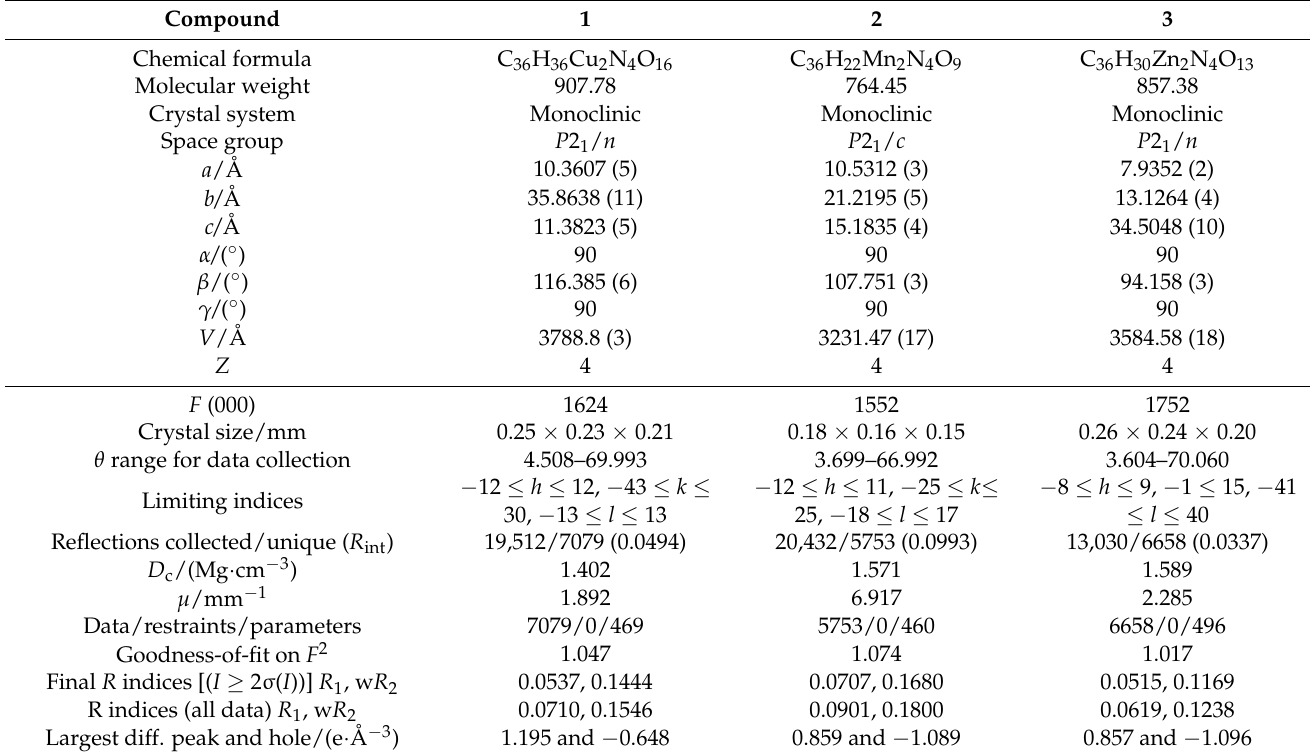
Table 3. Crystal data for CPs 1 − 3 .